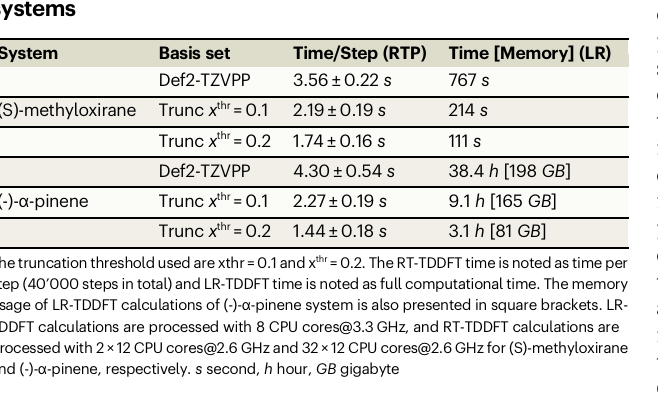
Fig. 4 | RT-TDDFT calculations of ( S )-methyloxirane, ZnPc, and the Ag 20 (except for the addition truncation on the Zn atom). d RT-TDDFT/LR-TDDFT structures. ( S )-methyloxirane a electronic absorption spectra and b electronic electronic absorption spectra using 6-31G(d,p), 6-31G(d), 6-31G, and 6-31G(d,p) CBS-10 − 6 basis sets for ZnPc system (stick spectra below correspond to LR-TDDFT circular dichroism spectra using original and truncated basis sets of def2-TZVPP ones). e Ag 20 geometry with colored vertex atoms (top), colored edge atoms (stick spectra below correspond to LR-TDDFT ones). c Number of deleted basis ∣ )andcorrespondingJaccardindicesof6-31G(d,p)basissetfor (middle),andcoloredfaceatoms(bottom). f Ag 20 LR-TDDFTelectronicabsorption functions( ∣ f χ μ g deleted ZnPc system. Purple, red, green, and blue dashed lines represent different x thr values,andthecorrespondingcolorednotationsgivethedeletedbasisfunctionsin italic form. Note that the red dashed line with x thr =0.09 and blue dashed line with x thr =0.18essentiallyreduce6-31G(d,p)to6-31G(d)and6-31Gbasisset,respectively